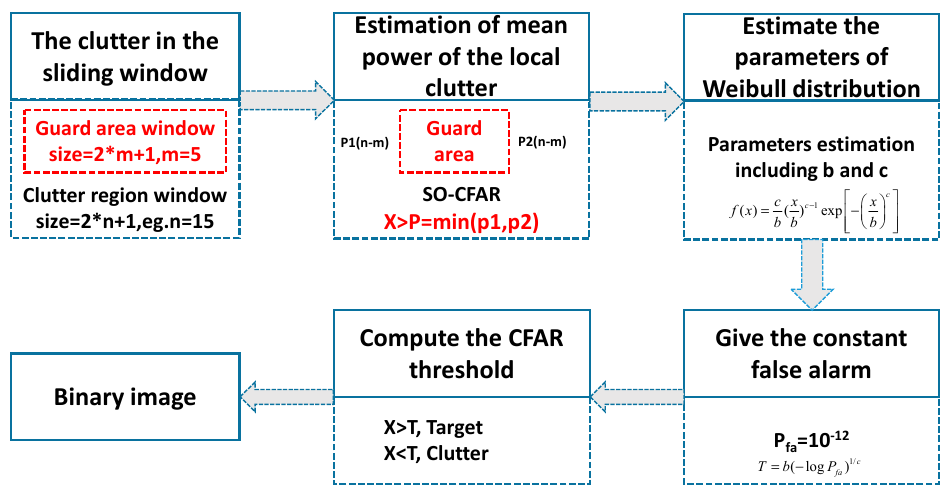
Figure 2. Flowchart of the SO-CFAR method for ice shelf detection.